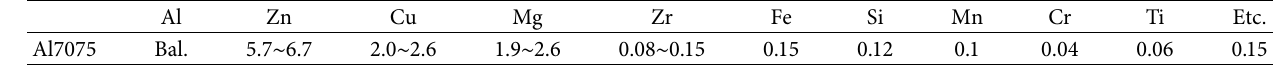
Table 2: Chemical compositions of Al7075-T7351.